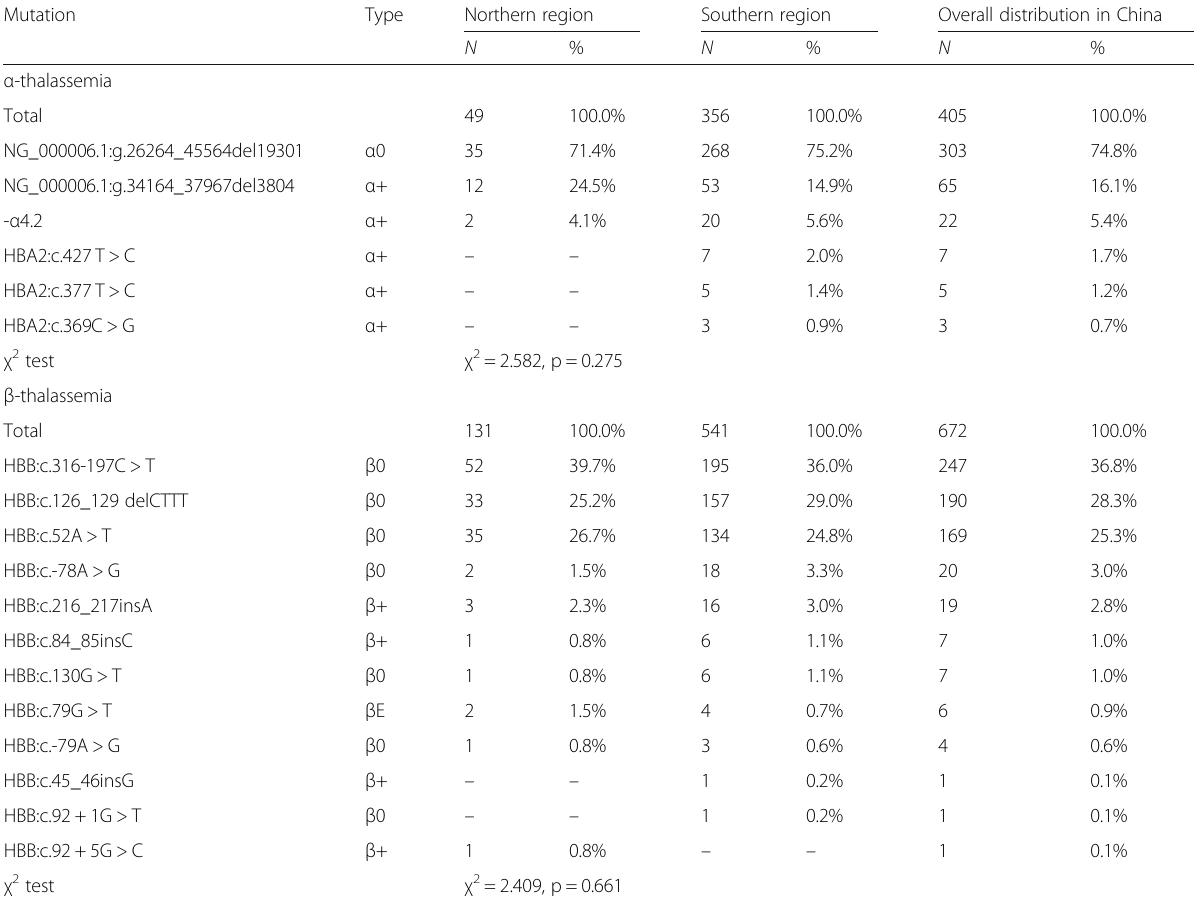
Table Legend: N =number of patients, % number of events/total number of patients*100; p -value for the χ 2 test are performed. Significant differences ( p <0.05) are highlighted in